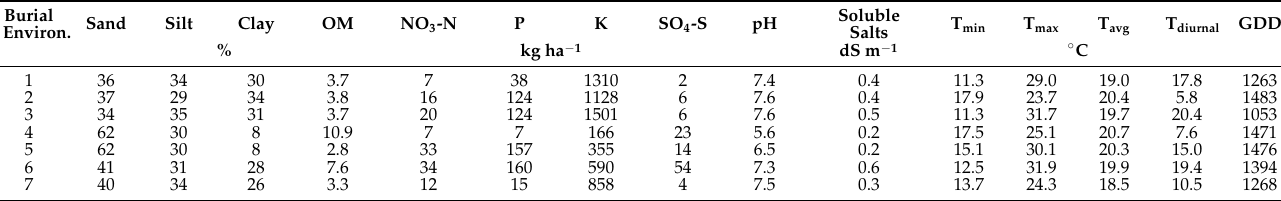
Table 2. Soil edaphic factors and seed microsite characteristics for each of seven burial environments included in a 7 week bioassay assessing the impact of crop species on seed mortality of kochia, wild oat, and volunteer canola a . Burial Environ. Sand